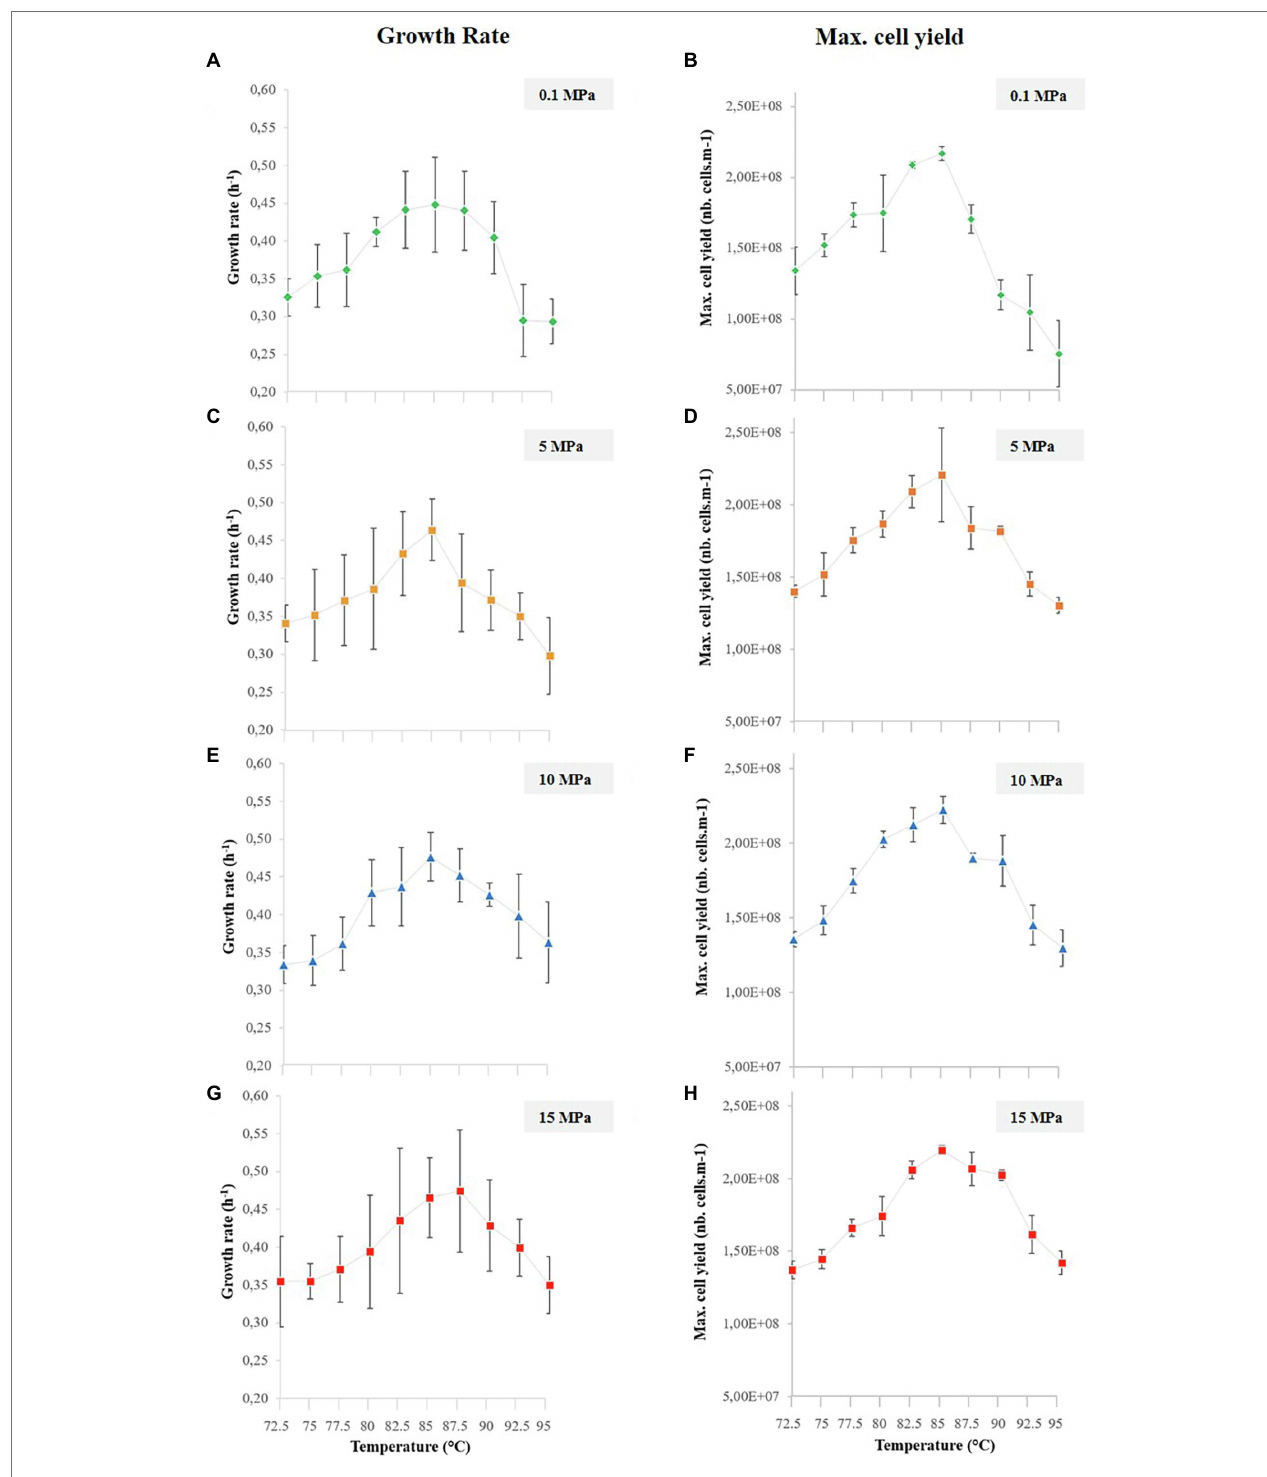
FIGURE 4 | Thermococcus barophilus growth rates (left column) and maximal cell yields (right column) over 10 temperature conditions (i.e., 72.5 ° C–95 ° C) for several pressure conditions, while growing in the temperature gradient on-a-chip: (A) T. barophilus growth rates at 0.1 MPa. (B) T. barophilus maximum cell densities at 0.1 MPa. (C) T. barophilus growth rates at 5 MPa. (D) T. barophilus maximum cell densities at 5 MPa. (E) T. barophilus growth rates at 10 MPa. (F) T. barophilus maximum cell densities at 10 MPa. (G) T. barophilus growth rates at 15 MPa. (H) T. barophilus maximum cell densities at 15 MPa. Error bars represent the SD